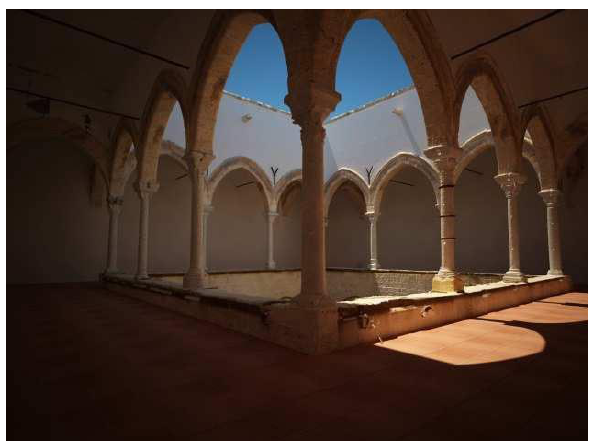
Figure 15. 3D photorealistic model – first